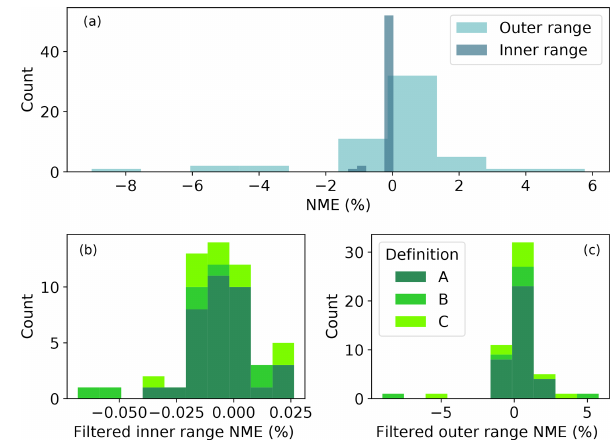
Figure C1. Histogram of NMEs using the baseline method: (a) NMEs of inner range (dark blue) and outer range (light blue) before filtering; (b) inner range NMEs after filtering out the submis- sions with absolute NMEs larger than 1%, categorized into three inner range definitions – definition A in dark green, definition B in green, and definition C in lime; (c) outer range NMEs categorized into three inner range definitions with the same color scheme as in (b) .